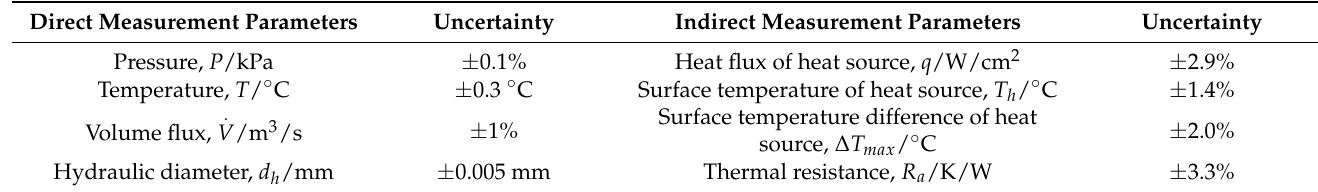
Table 1. Uncertainty of parameters.